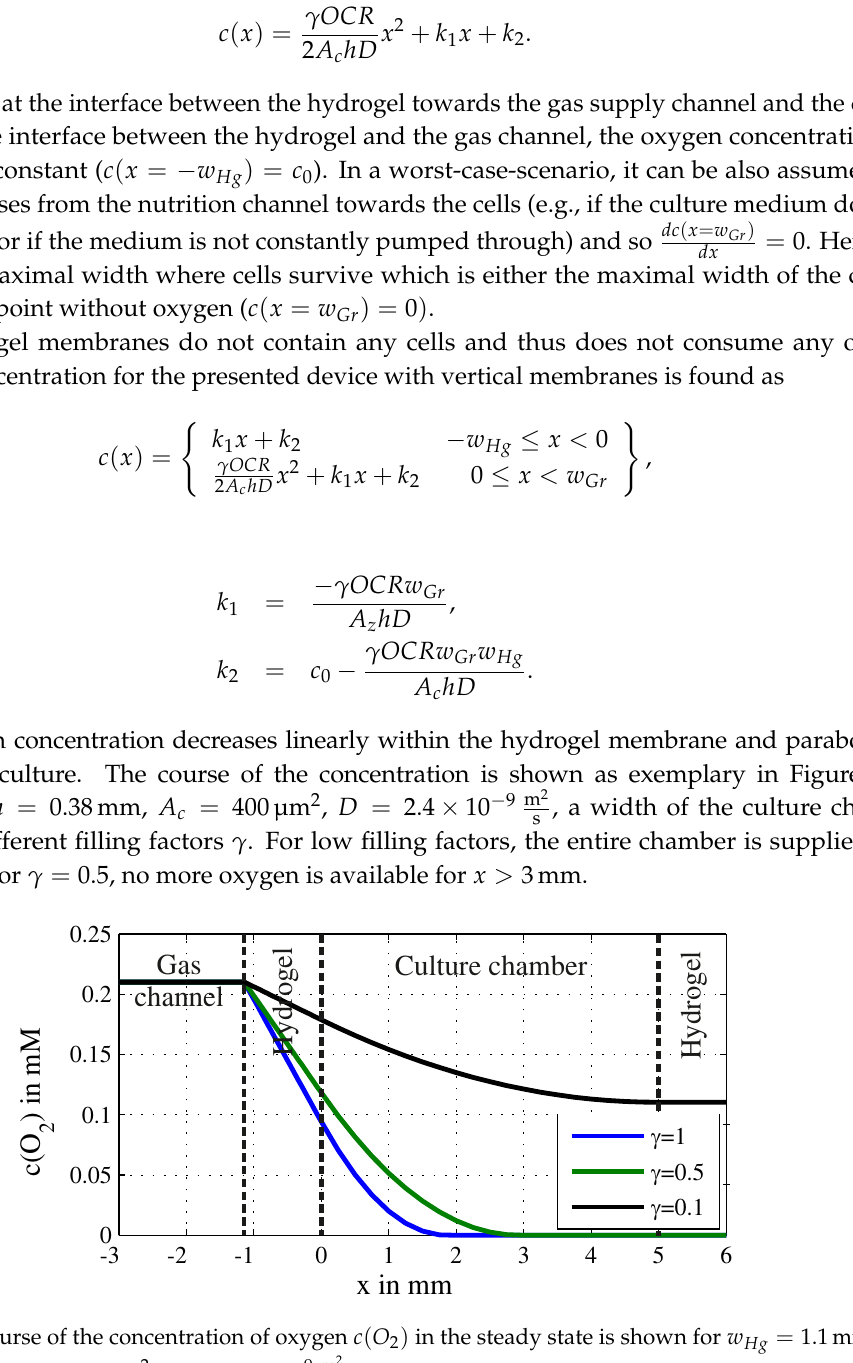
, a width of the culture chamber of 5mm and different s